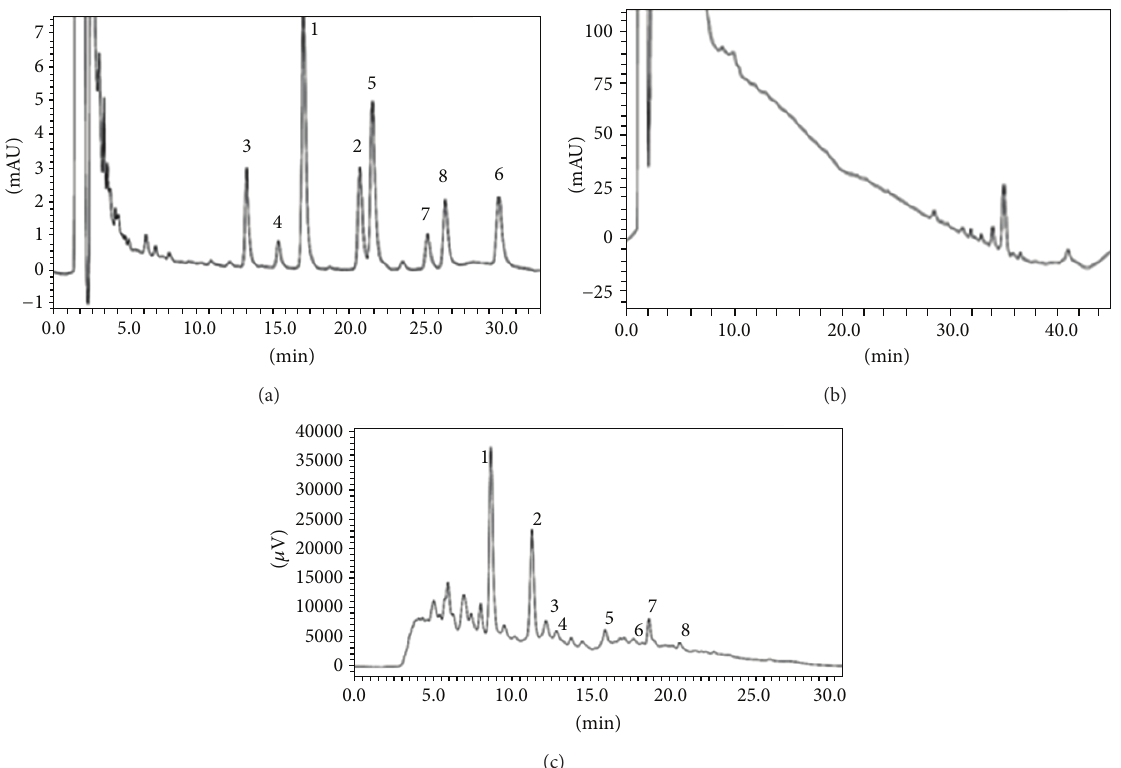
Figure 1: Chromatographic profile of aqueous extract of Uncaria tomentosa at 245, 245, and 325 nm, respectively. (a) OA (6), (b) QAD (7), and (c) LMP (5).